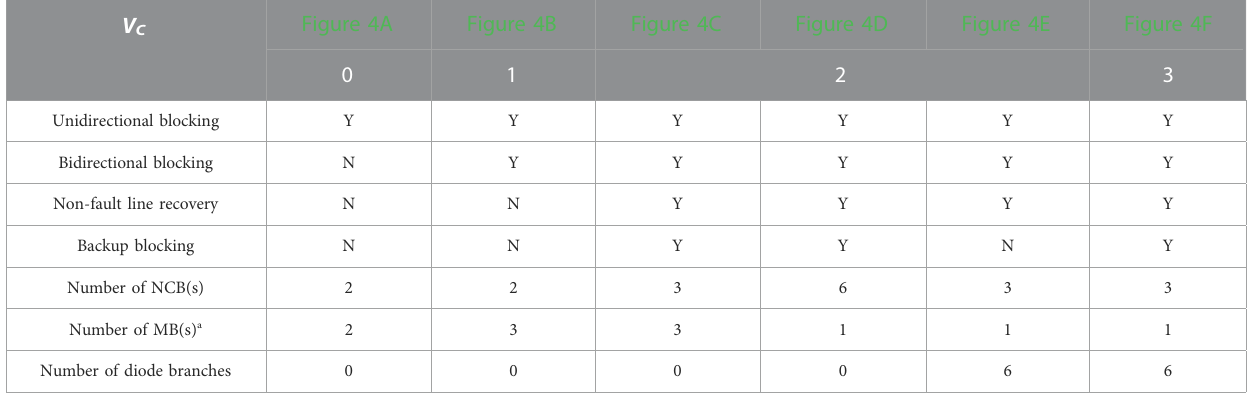
TABLE 3 Characteristics and comparison of previous